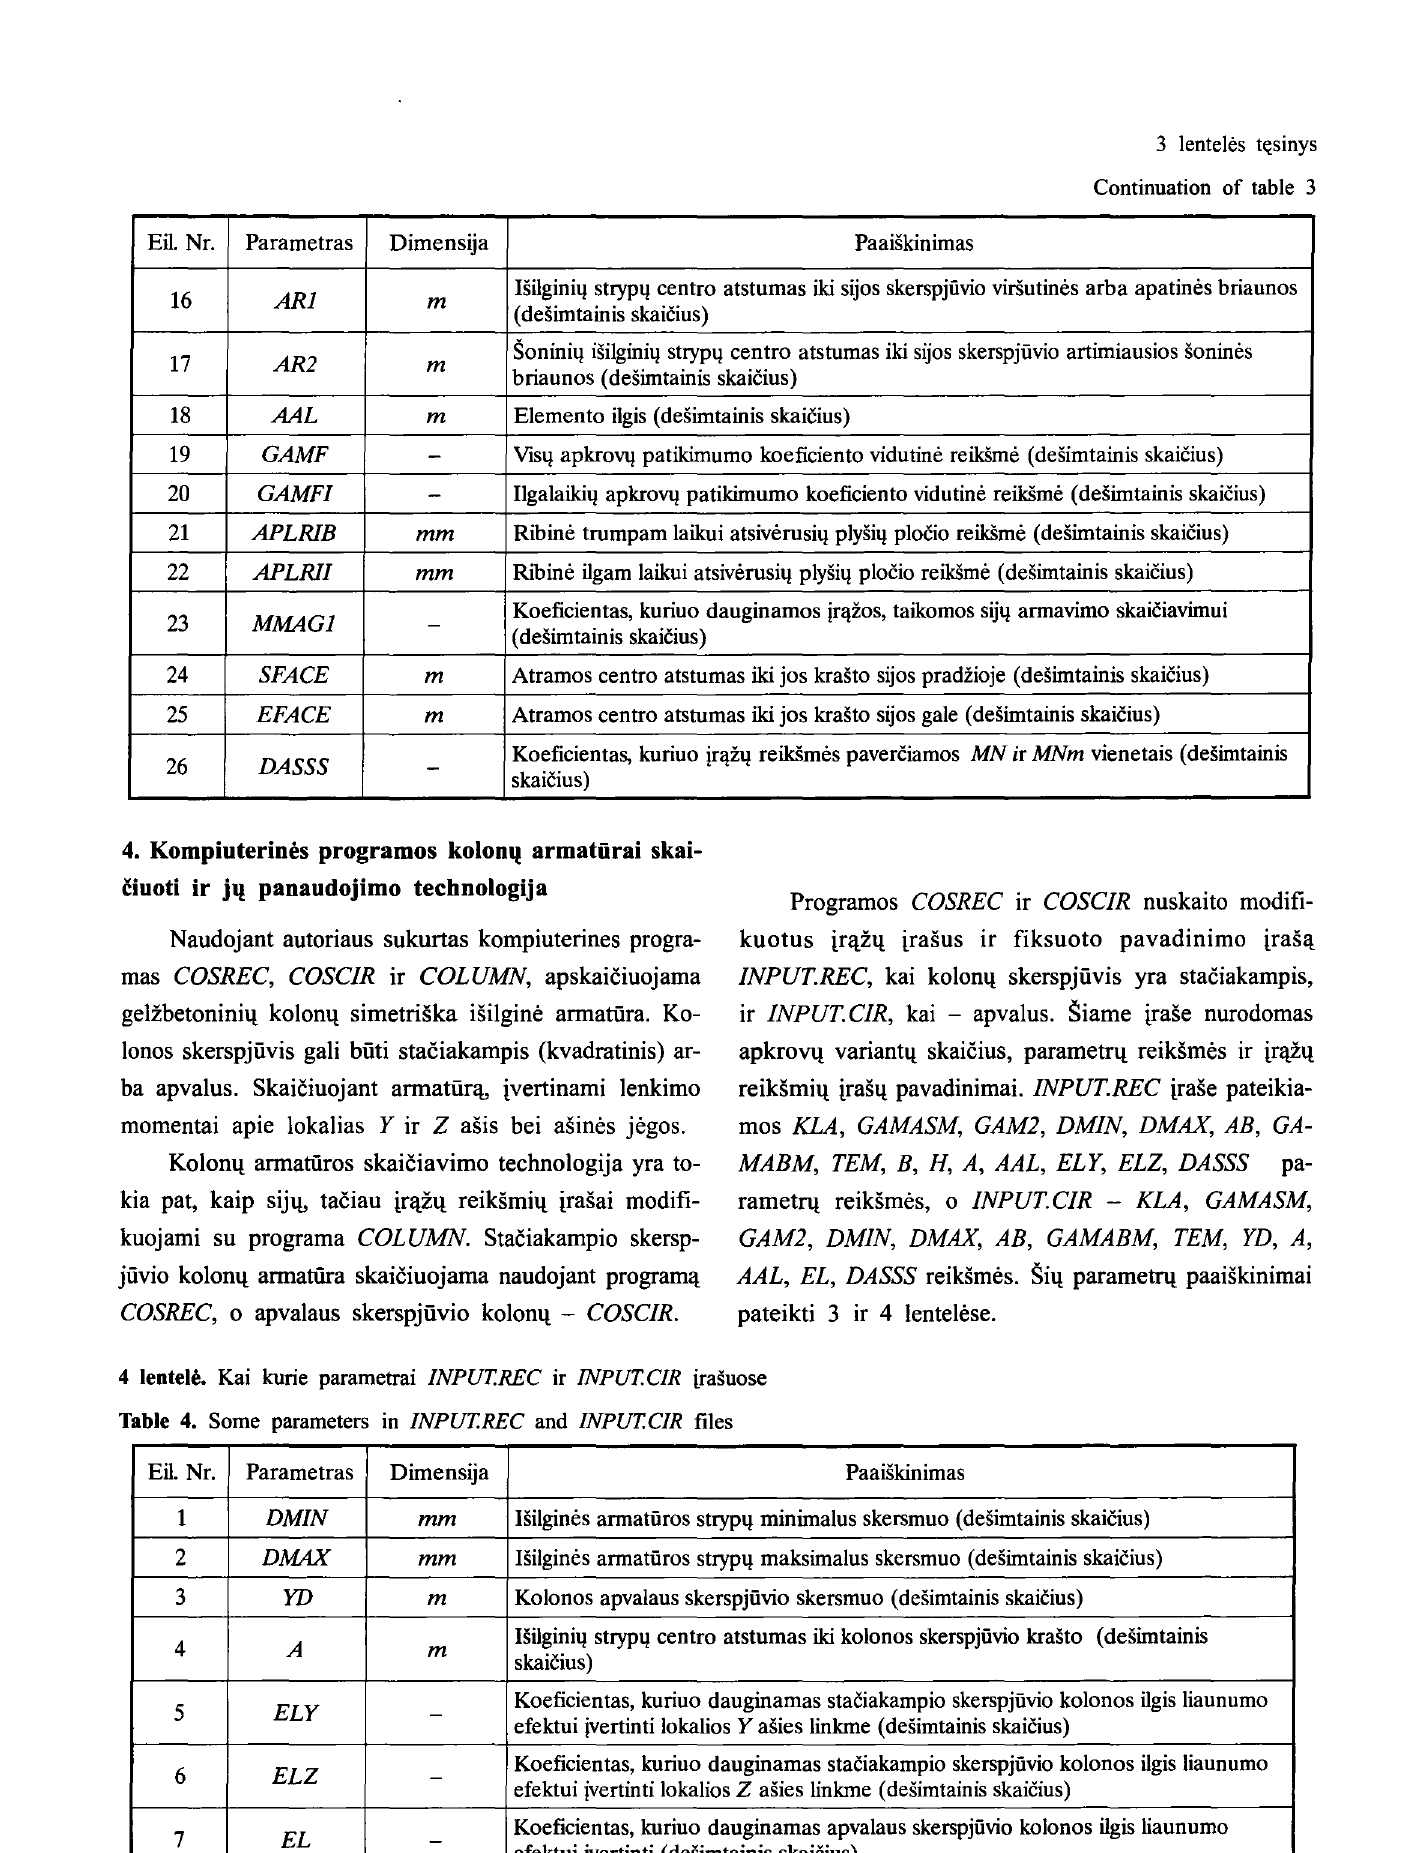
Table 4. Some parameters in INPUT.REC and INPUT.CIR files Eil.